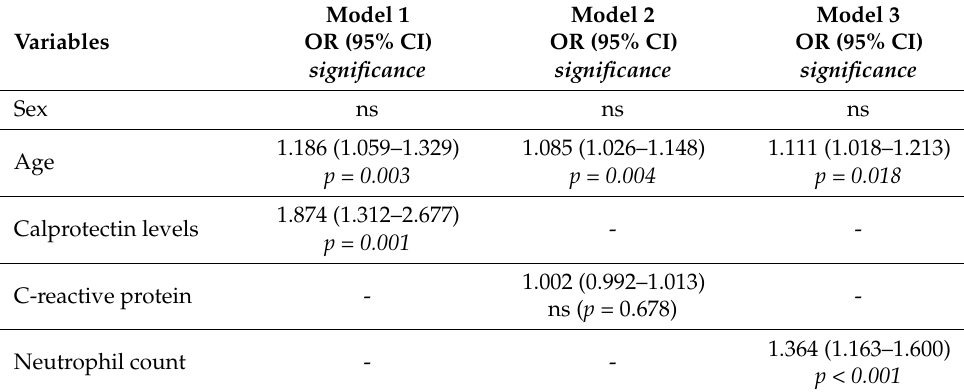
Table 2. Results of multivariate logistic analyses.